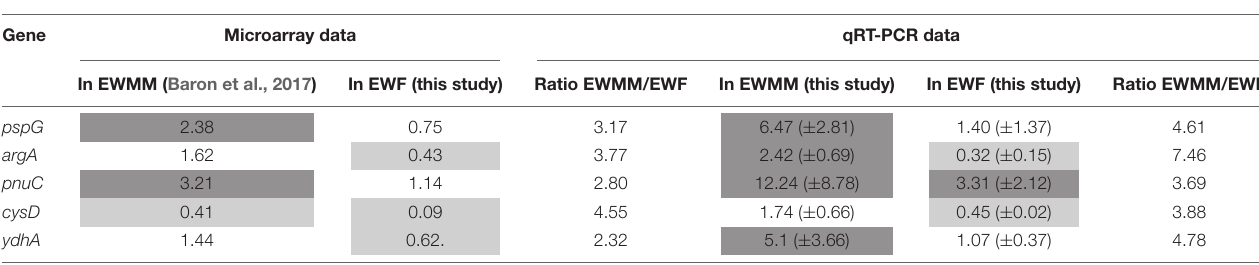
TABLE 3 | Confirmation of selected genes by qRT-PCR